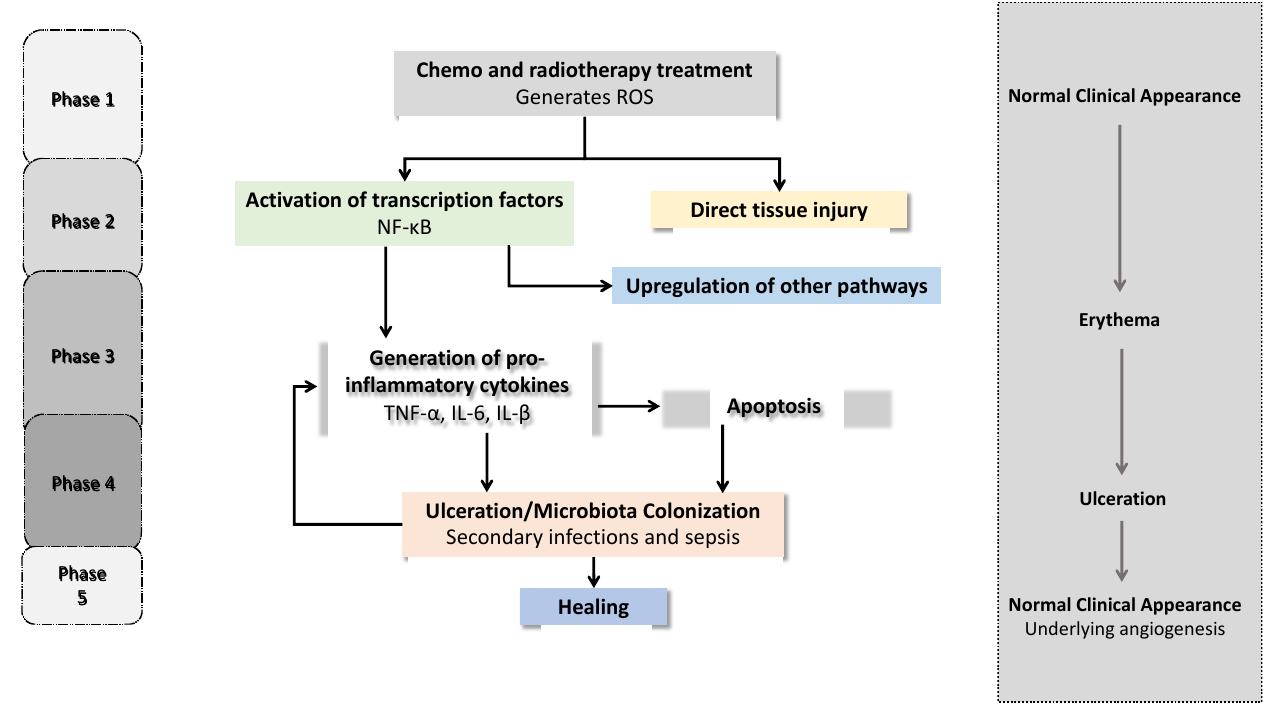
Figure 1. Diagram representing the mucosal cells and clinical manifestations of oral mucositis. The mucositis initiation phase—initiation—corresponds to the injury of oral mucosal cells caused by CT and/or RT. This phase begins instantaneously as the antineoplastic treatment is being administered [5,6,48,49]. The second phase—upregulation with mes ‐ senger generation—involves the cytotoxic effect, resulting in the generation of reactive oxygen and nitrogen species (ROS and RNS, respectively) and DNA damage, leading to basal and suprabasal epithelial cell death [2,3,6]. Particularly, when DNA strands breaks, the apoptotic process is activated, with p53 and nuclear factor κ B (NF ‐ κ B) playing major roles [50,51]. At this point, inflammatory cytokines, chemokines, and adhesion molecules are generated when NF ‐ κ B, the key mediator of pro ‐ inflammatory gene expression, is activated, which is clinically manifested as mucosal damage. The release of pro ‐ inflam ‐ matory cytokines, such as tumor necrosis factor (TNF ‐α ), interleukin ‐ 1 β (IL ‐ 1 β ), and in ‐ terleukin ‐ 6 (IL ‐ 6), is mediated through transcription factor activation, and this promotes connective tissue and endothelial damage, limiting the tissue oxygenation and stimulat ‐ ing epithelial basal cell death [2,18,50–53]. The third phase—signaling and amplification—